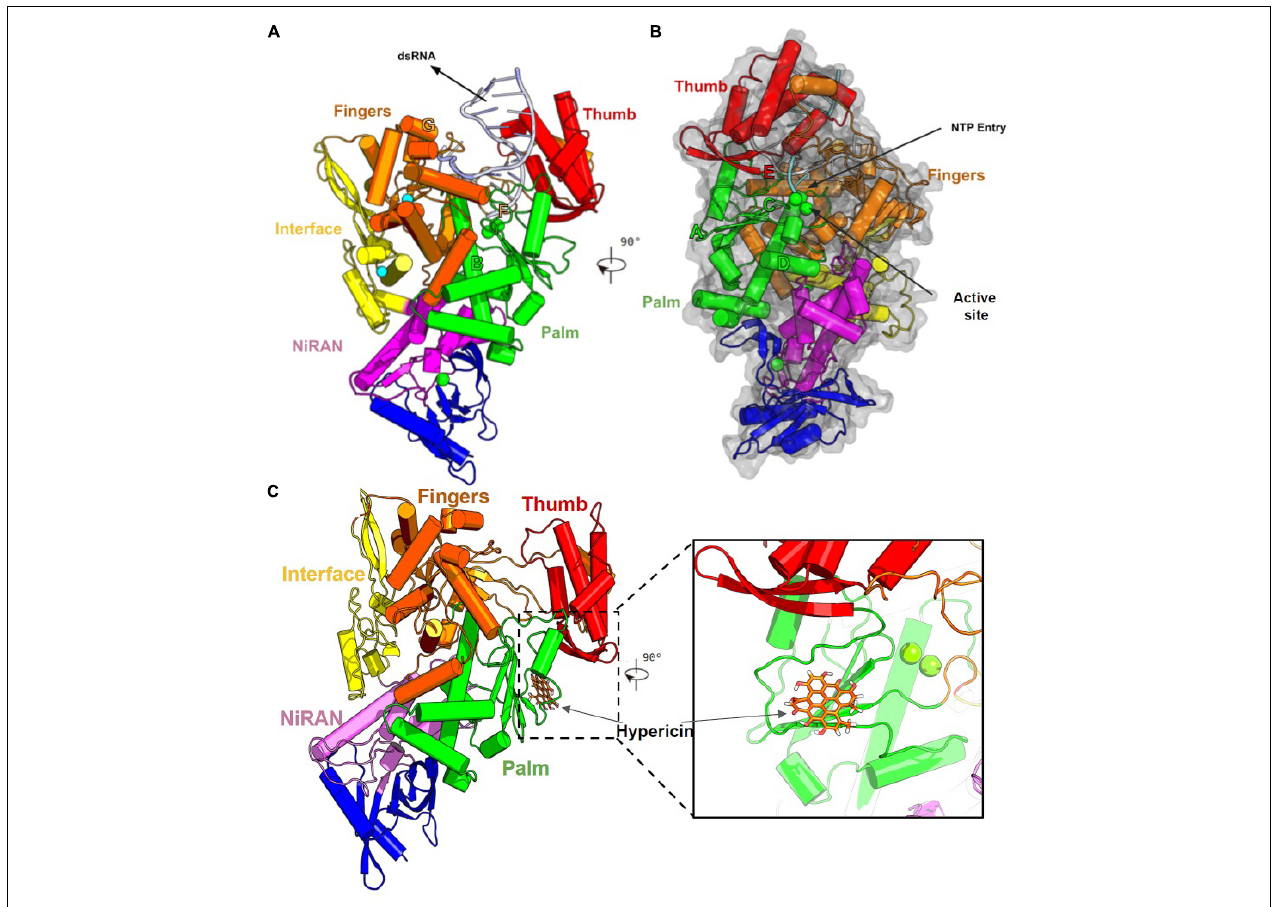
FIGURE 1 | Structure of the SARS-CoV-2 RdRp polymerase in complex with Hypericin. (A) General structure of SARS-CoV2 RdRp and important parts of the active site. The Structure of SARS-CoV2 RdRp (NSP12) core contains an interface (Yellow), Nidovirus RdRp-associated nucleotidyltransferase (NiRAN in Magenta), and RdRp domains. The RdRp domain looks like a right hand containing the Thumb (in red), Palm (in green), and Finger (in orange) subdomains. (B) SARS-CoV2 presents a catalytic triad (GDD) at the center of the Palm subdomain that catalyzes the synthesis of an RNA strand complementary to the RNA template through the binding of NTP’s. Furthermore, the RdRp have six motifs named A to F that are well conserved. These motifs are responsible for template binding (Motif B), polymerization and recognition of NTPs (Motif D), coordination of ions and active site (motif A and C), conformational changes and support of the primer strand (Motif E). (C) Our docking calculations show that Hypericin interacts in the palm domain of RdRp near the catalytic center, represented by Mg ions. In this position, Hypericin blocks the natural pathway of ribonucleotides in the active site of the RdRp enzyme. Secondary structure of RpRd enzyme represented in cartoon style and colored according to protein domains, Mg ions represented in VDW and Hypericin is represented in orange